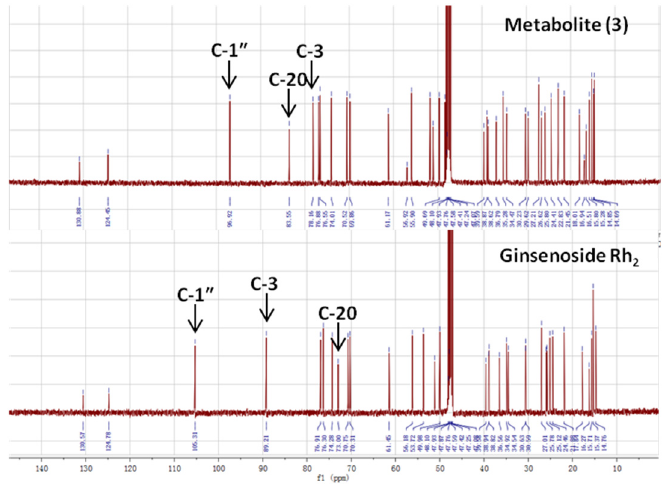
Figure 11. HRMS data of metabolite (3).